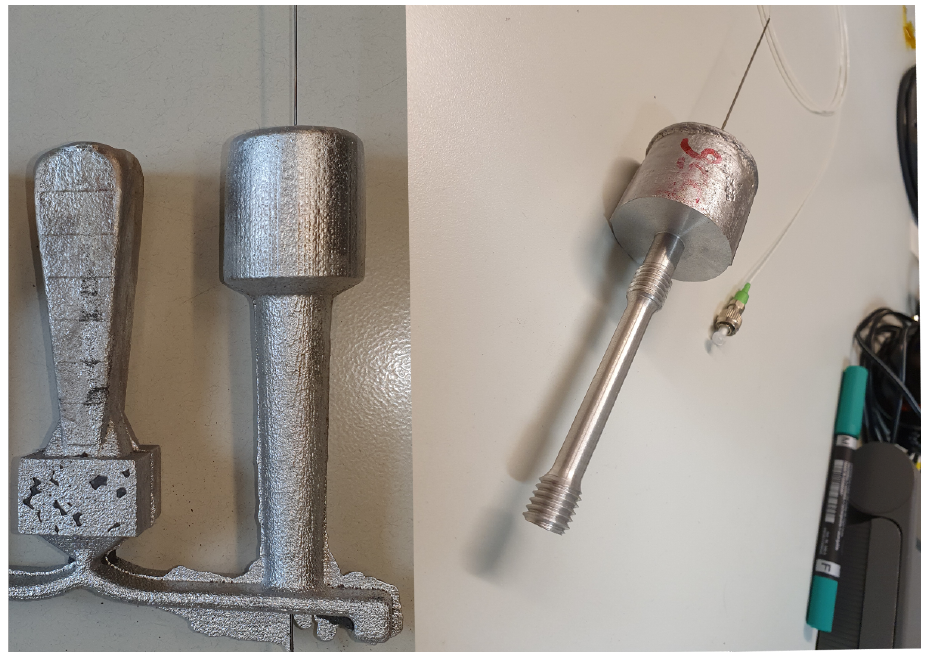
Figure 5. Picture of one arm of a cast part with the embedded FBG strain sensor after casting (left) and after machining (right). The casted part was machined to create a tensile test specimen according to DIN50125 with threaded